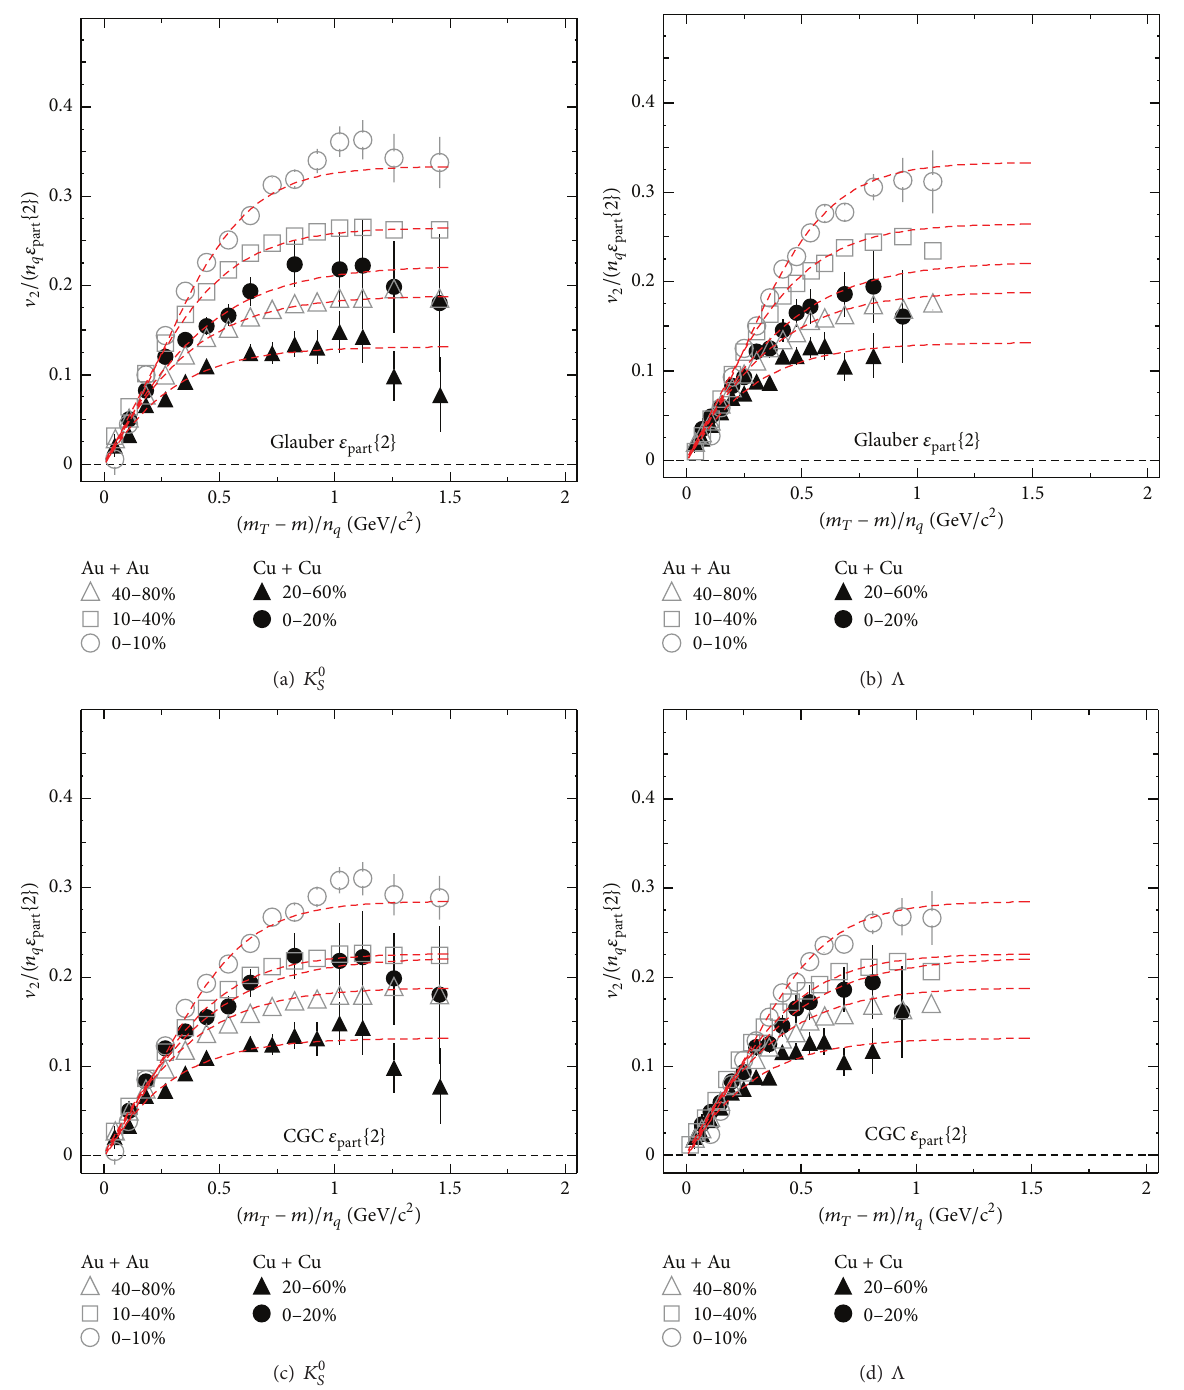
Figure 1: Centrality dependence of V 2 scaled by number of quarks and participant eccentricity ( V 2 /(𝑛 𝑞 𝜀 part {2}) ) for 𝐾 0 𝑆 and Λ as a function of ( 𝑚 𝑇 − 𝑚 )/ 𝑛 𝑞 in 0–10%, 10–40%, and 40–80% Au + Au collisions and 0–20% and 20–60% Cu + Cu collisions at √𝑠 𝑁𝑁 = 200 GeV [14].